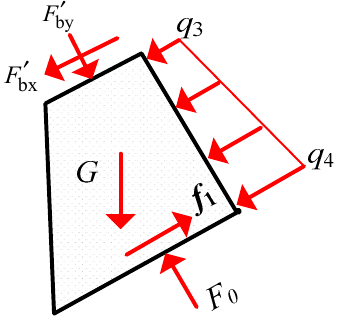
Figure 5. Mechanical model of filling body of gob-side entry retention work in steeply inclined coal seam.